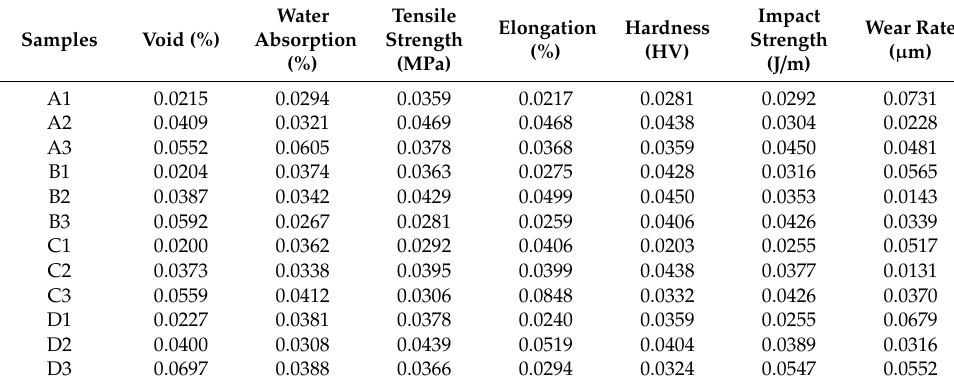
Table 7. Weight normalized matrix.